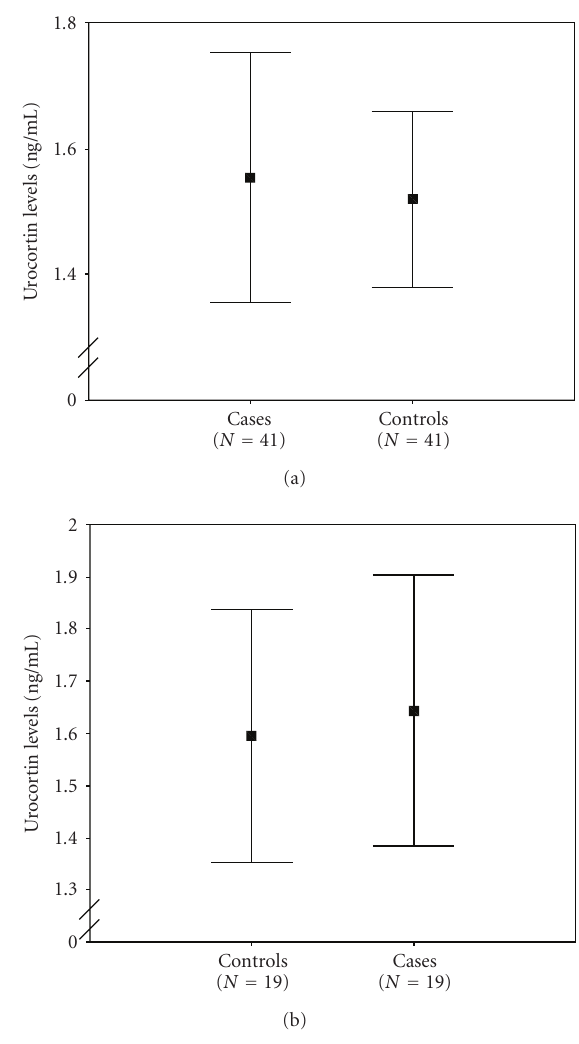
Figure 1: (a) Error bars of the concentrations of amniotic fluid urocortin from women with preterm delivery (cases) (Mean ± SD: 1.55 ± 0.63 ng/mL) and fullterm delivery (controls) (Mean ± SD:1.52 ± 0.43 ng/mL). Each box represents the mean (95% CI) concentration. (b) Error bars of the concentrations of amniotic fluid urocortin from women with preterm delivery and premature rupture of membranes (cases) (Mean ± SD:1.64 ± 0.54 ng/mL) and women with fullterm delivery (controls) (Mean ± SD: 1.6 ± 0.49 ng/mL). Each box represents the mean (95% CI) concentra-